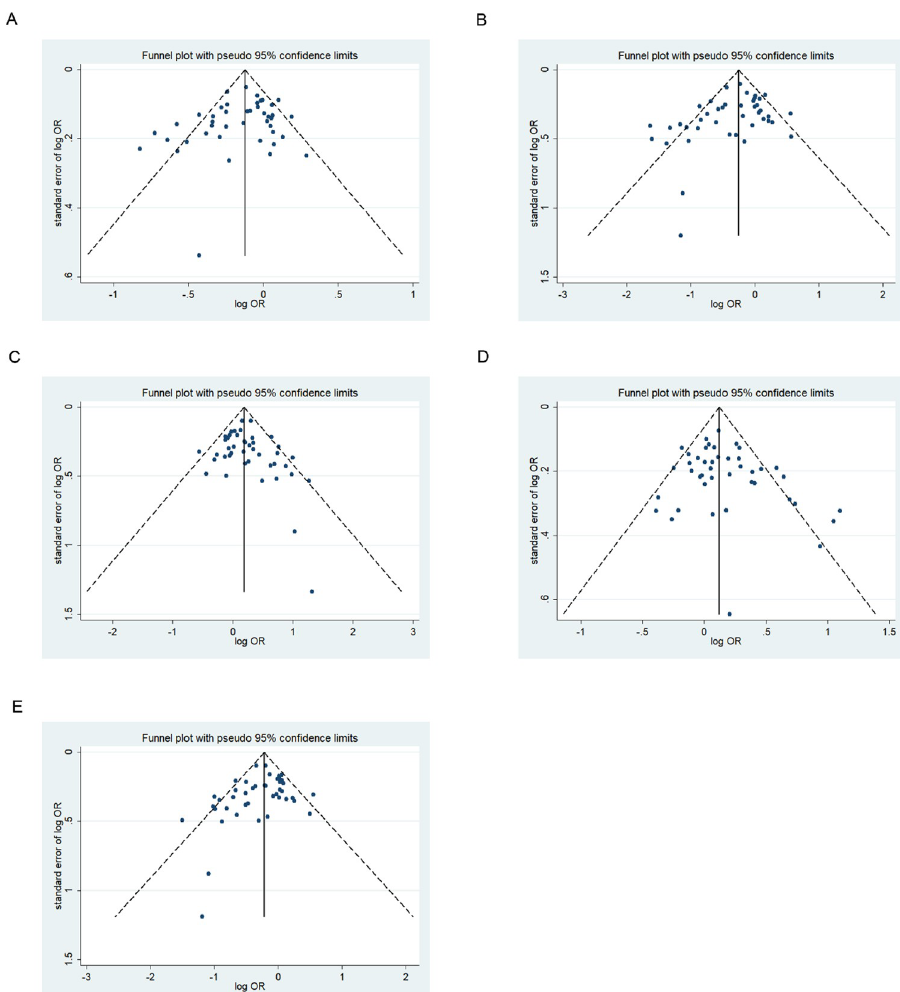
Fig 12. Funnel plot analysis depicting publication bias in the association between MTHFR 677C > T polymorphism and schizophrenia in the five genetic models (A, allele contrast; B, homozygous codominant; C, heterozygous codominant; D, dominant; and E,